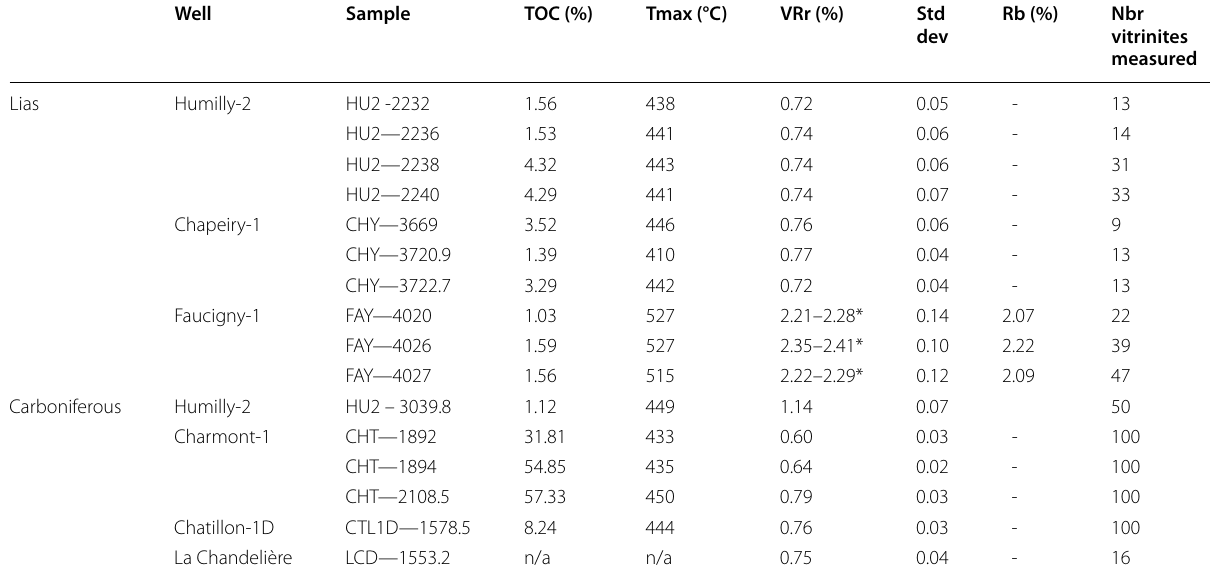
*Vitrinite reflectance ranges calculated from bitumen reflectance according to Landis and Castaño (1995) and Schoenherr et al.